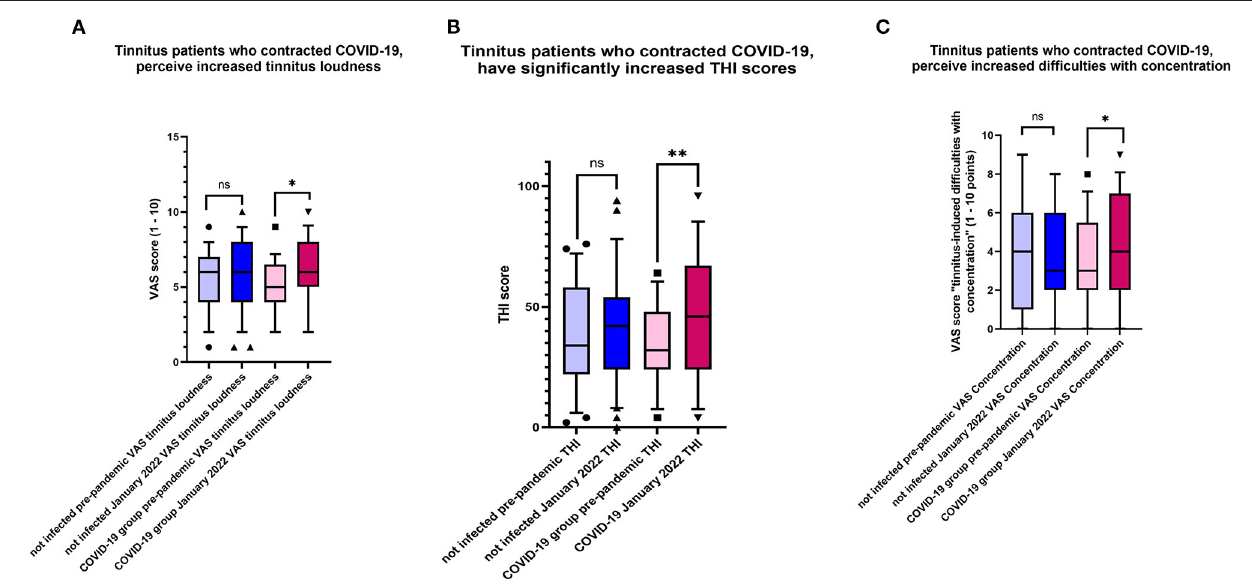
FIGURE 4 | (A) Changes characteristic for tinnitus patients who contracted COVID-19. Plotted are the values indicating tinnitus loudness before the pandemic and January 2022. Shown is the box & whiskers plot (5–95 percentile), Wilcoxon paired test (* p = 0.0006; ns, not significant). (B) Changes characteristic for tinnitus patients who contracted COVID-19. Plotted are the values indicating THI scores before the pandemic and January 2022. Shown is the box & whiskers plot (5–95 percentile), Wilcoxon paired test (** p < 0.0001; ns, not significant). (C) Changes characteristic for tinnitus patients who contracted COVID-19. Plotted are the values indicating VAS scores “tinnitus-induced difficulties with concentration” before the pandemic and January 2022. Shown is the box & whiskers plot (5–95 percentile), Wilcoxon paired test (* p = 0.019; ns, not significant).